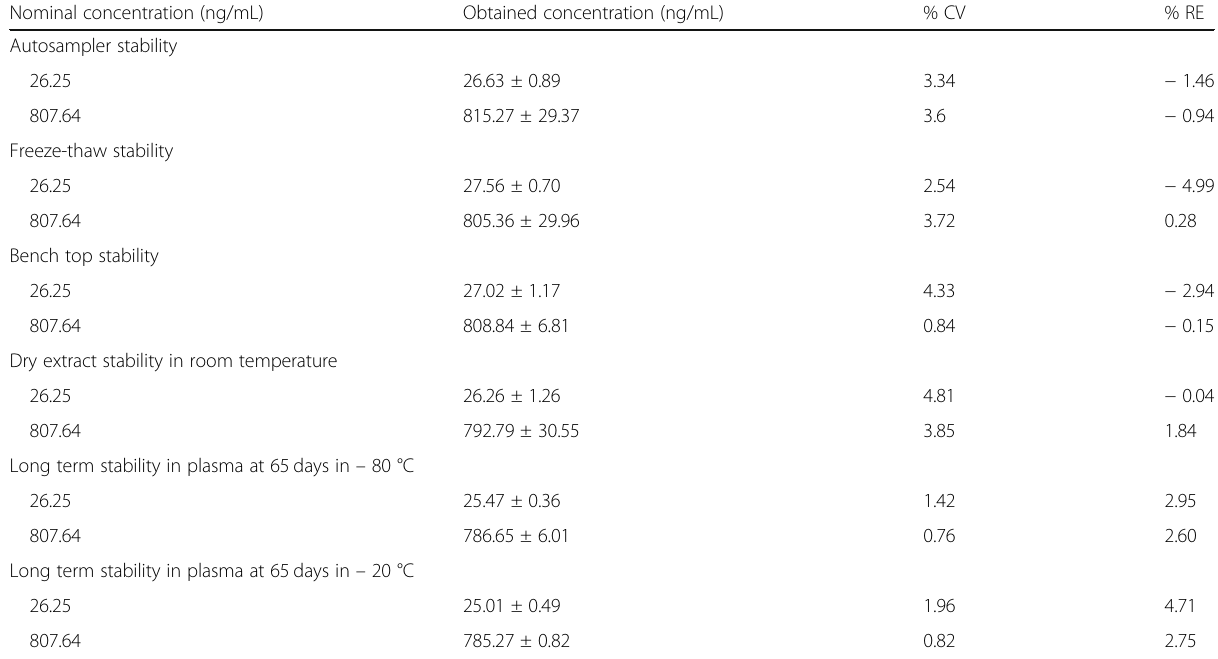
Table 4 Stability of lenalidomide in plasma samples Nominal concentration (ng/mL) Obtained concentration (ng/mL) % CV %